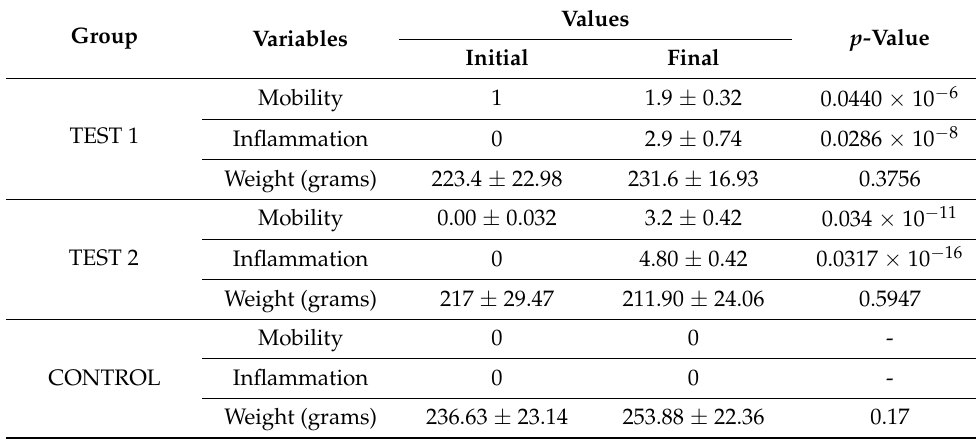
Table 1. Clinical parameters, before and after periodontal disease induction. Group